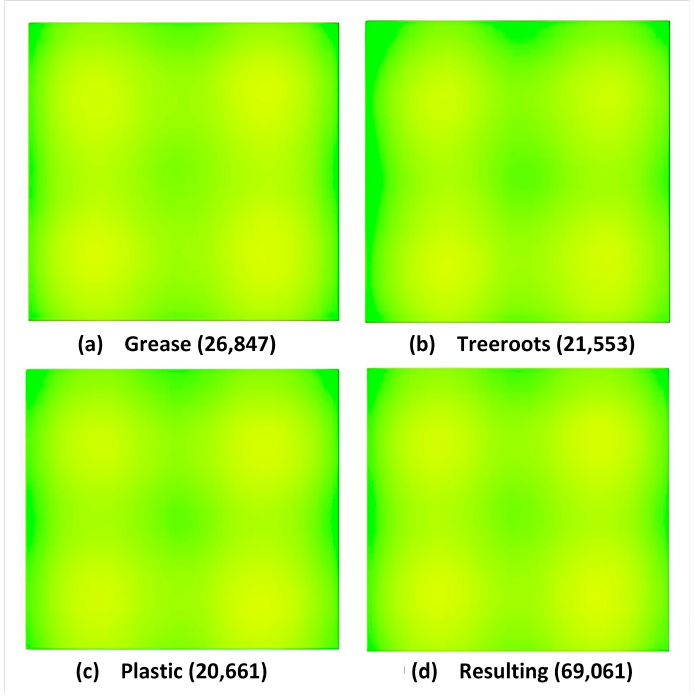
Figure 15. Annotation heatmap details for all classes. A histogram is a chart that plots numeric data into bins represented by individual columns. Figure 16 details the number of frames on the y-axis and bins, i.e., the number of corresponding objects for all classes on x-axis, with the help of the object count histogram.